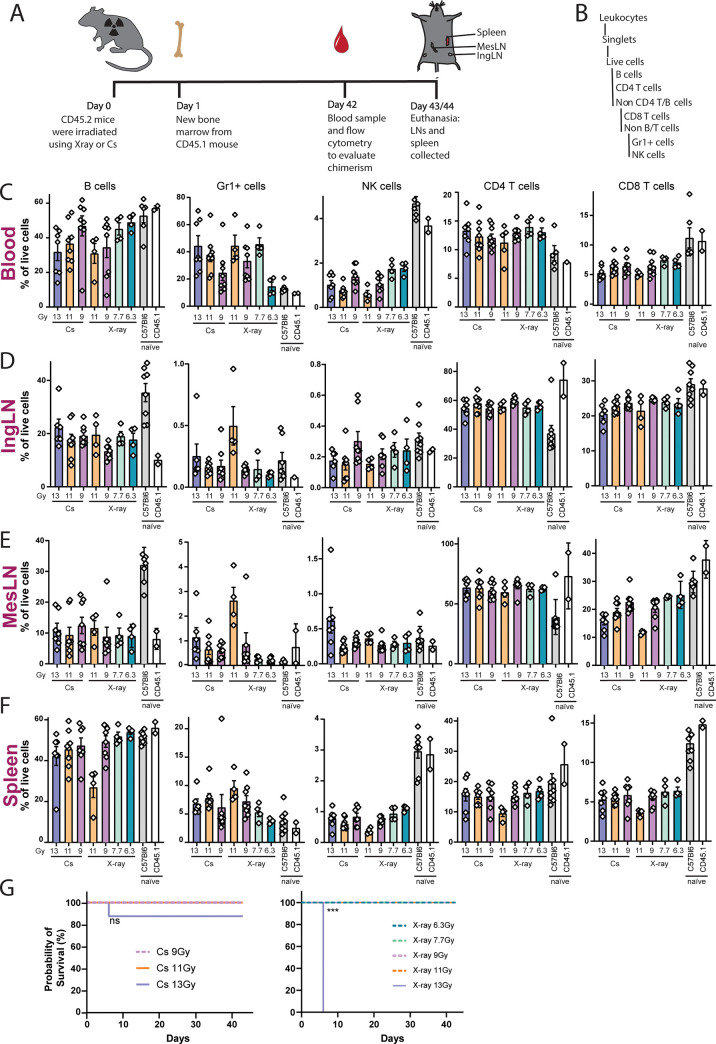
The irradiation of mice using Cesium-137 (Cs-137) or X-ray affects the levels of B, Gr1+, NK, CD4 T and CD8 T cells similarly.A) Schematic illustration of experimental layout. B) Gating tree used for flow cytometry data, gating layout can be seen in S1A Fig. Percentages of immune cells in blood (C), IngLN (D), MesLN (E) and spleen (F) after Cs-137 irradiation at doses of 9 (n = 8), 11 (n = 8) and 13 (n = 6) Gy or X-ray irradiation at doses of 6.3 (n = 4), 7.7 (n = 4), 9 (n = 7) and 11 (n = 4) Gy. Naïve mice have not been exposed to any treatment. In all bar graphs, the bar indicates the mean and error bars indicate the standard error of mean. For blood measurements, Kruskal-Wallis test indicated significant differences between medians within Gr1+ cells (P = 0.01) and NK cells (P = 0.016), with significant differences for Dunn’s pairwise comparison within NK cells for 11 Gy Cs-137 vs. 7.7 Gy X-ray (P = 0.047), 11 Gy Cs-137 vs. 6.3 Gy (P = 0.0338), and 11 Gy X-ray vs. 6.3 Gy X-ray (P = 0.0495). For IngLN, Kruskall-Wallis test indicated only significantly different medians among Gr1+ cells (P = 0.035), with pairwise differences for 11 Gy X-ray vs. 6.3 Gy X-ray (P = 0.0227). For MesLN, Kruskal-Wallis test indicated significant differences between medians within Gr1+ (P = 0.0048) and CD8 T cells (P = 0.0001), with significant differences for Dunn’s pairwise comparison within Gr1+ for 11 Gy X-ray vs. 6.3 Gy X-ray (P = 0.0041) and within CD8 T cells for 13 Gy Cs-137 vs. 7.7 Gy X-ray (P = 0.0071), 9 Gy Cs-137 vs. 11 Gy X-ray (P = 0.0369), 11 Gy X-ray vs. 7.7 Gy X-ray (P = 0.0015) and 6.3 Gy X-ray (P = 0.0141). Finally, for spleen, significantly different medians were found among B (P = 0.0288), Gr1+ (P = 0.0021) and NK cells (P = 0.0046), with significant pairwise differences within B cells, 11 Gy X-ray vs. 6.3 Gy X-ray (P = 0.032), within Gr1+, 11 Gy Cs-137 vs. 6.3 Gy X-ray (P = 0.0475), 9 Gy Cs-137 vs 11 Gy X-ray (P = 0.0462), and 11 Gy X-ray vs. 6.3 Gy X-ray (P = 0.0193), and within NK cells, 11 Gy X-ray vs. 6.3 Gy X-ray (P = 0.0044). G) Survival curves for the mice after each irradiation dose. All mice receiving 13 Gy X-ray irradiation died or were euthanized as they reached a humane end-point. Statistical significance indicated for log-ranked Mantel-Cox test (***, p<0.001).